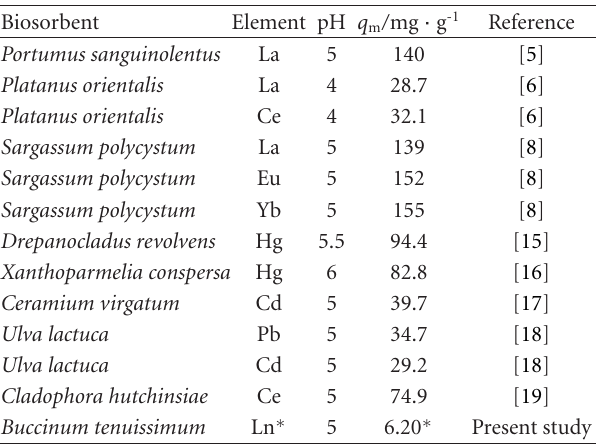
Table 7: Comparison of adsorption capacity of the biomass for lanthanides with that of di ff erent biosorbents for lanthanides including other